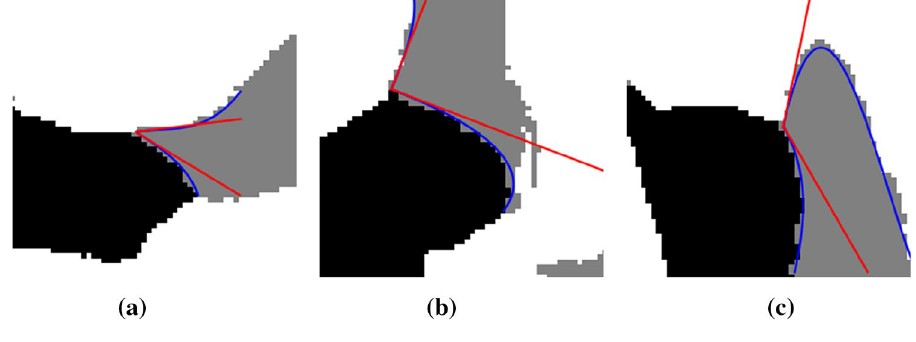
Fig. 8 Image processing of the X-ray image by using Method 3 in Fig.